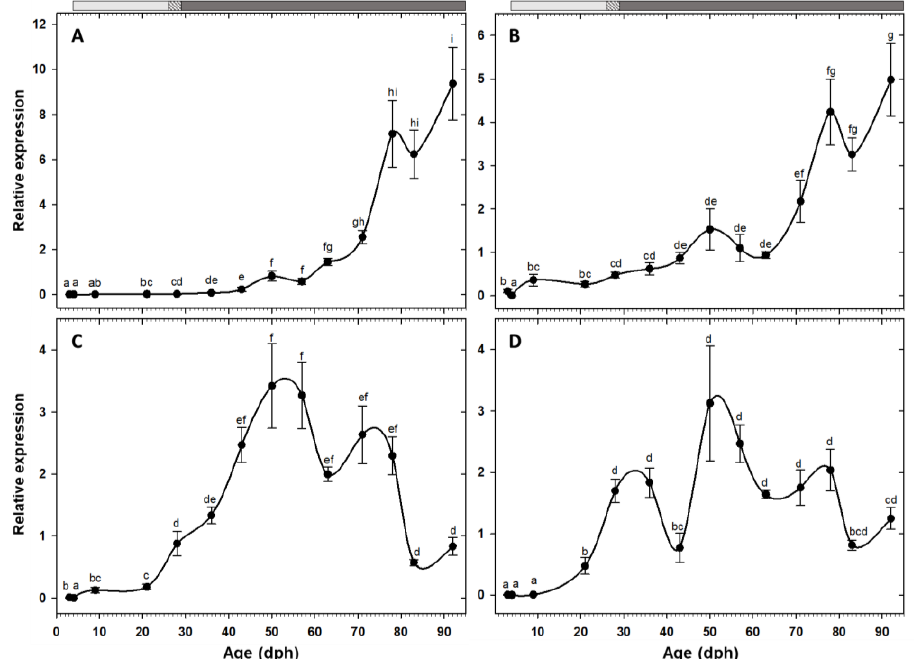
Figure 2. Transcriptional changes of genes related to protein digestion; try2 ( A ), ctr ( B ), pga2 ( C ), and atp4a ( D ) in whole-body C. labrosus individuals during development (N = 6 to 10 individuals per sampling point). Different letters denote statistically significant differences between sampling times ( p < 0.05). Light grey, dashed, and dark grey bars on top of the graph, represent periods with live prey, co-feeding, and inert diet, respectively.